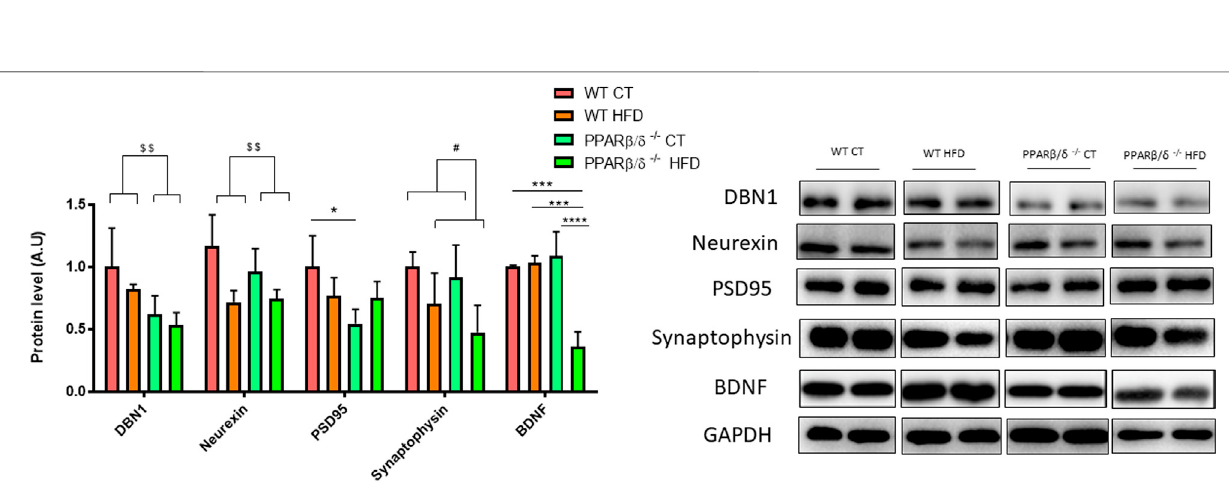
Frontiers in Pharmacology |